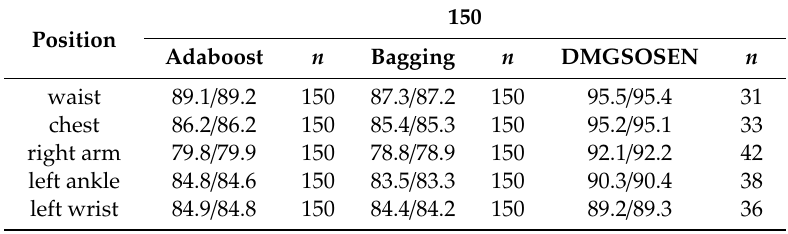
Table 13. Performance comparison with Adaboost and Bagging on 150 ELMs (Accuracy / F1%).